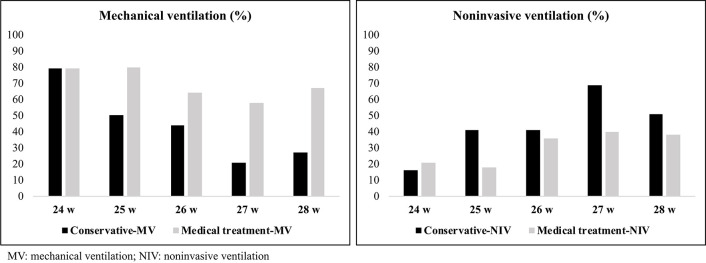
The respiratory support of infants and PDA management.